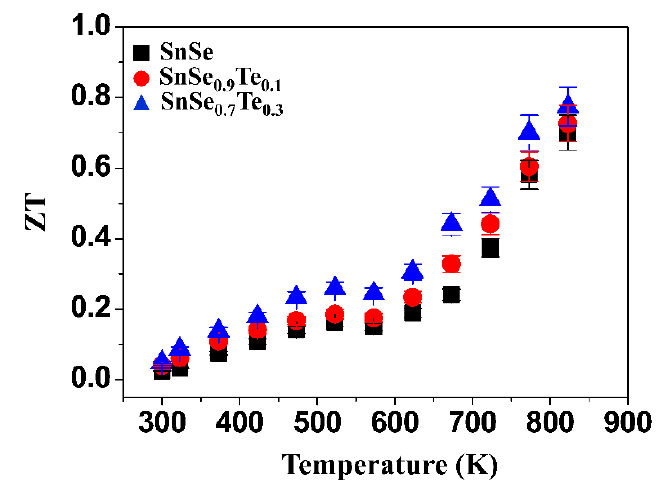
Figure 10. The figure of merits (ZTs) of the polycrystalline SnSe 1 − x Te x measured at different temperatures.